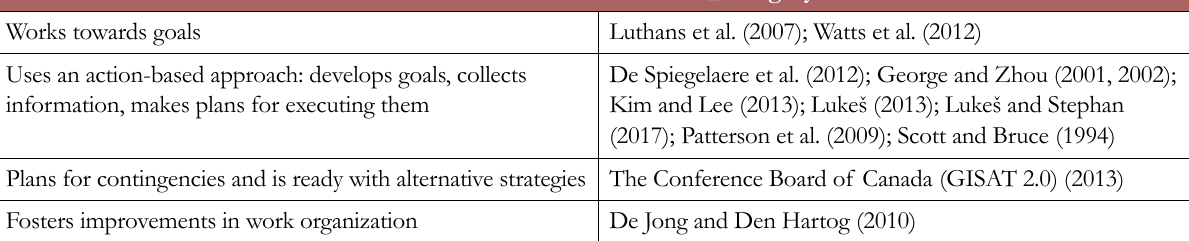
Table 14. Behaviours showing “organising the implementation of the work”